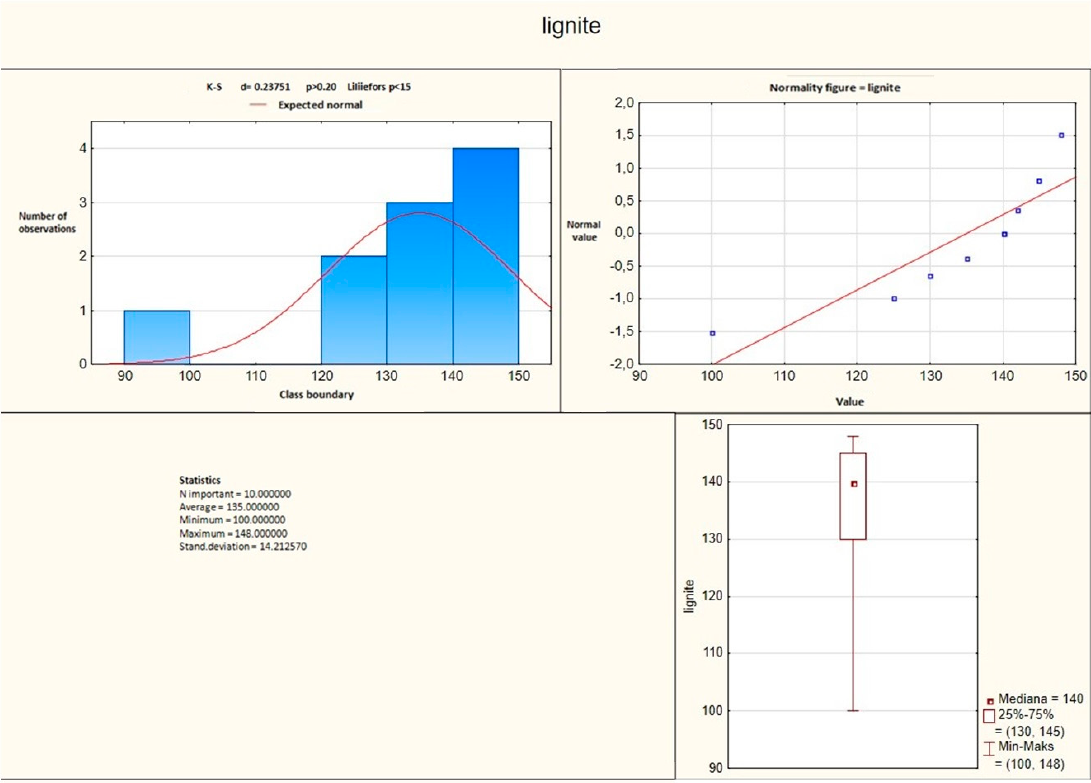
Figure 33. Statistical calculations for lignite.